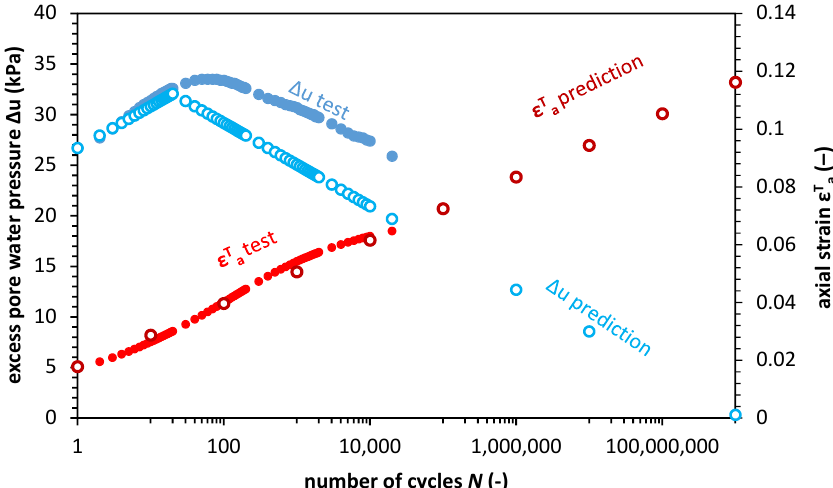
Figure 10. Excess pore pressure and axial strain test results and results of calculation with the prognosis for sample D.01.